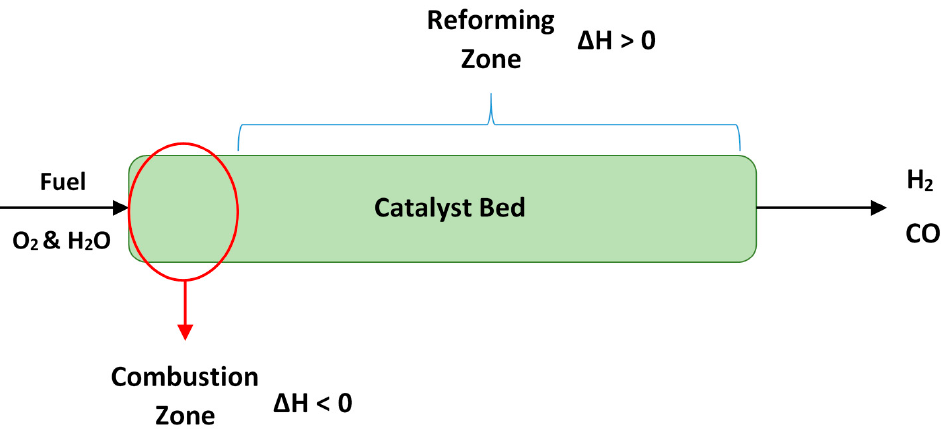
Figure 5. The combustion-reforming mechanism of the oxy-steam reforming (OSR) process: catalyst bed description.